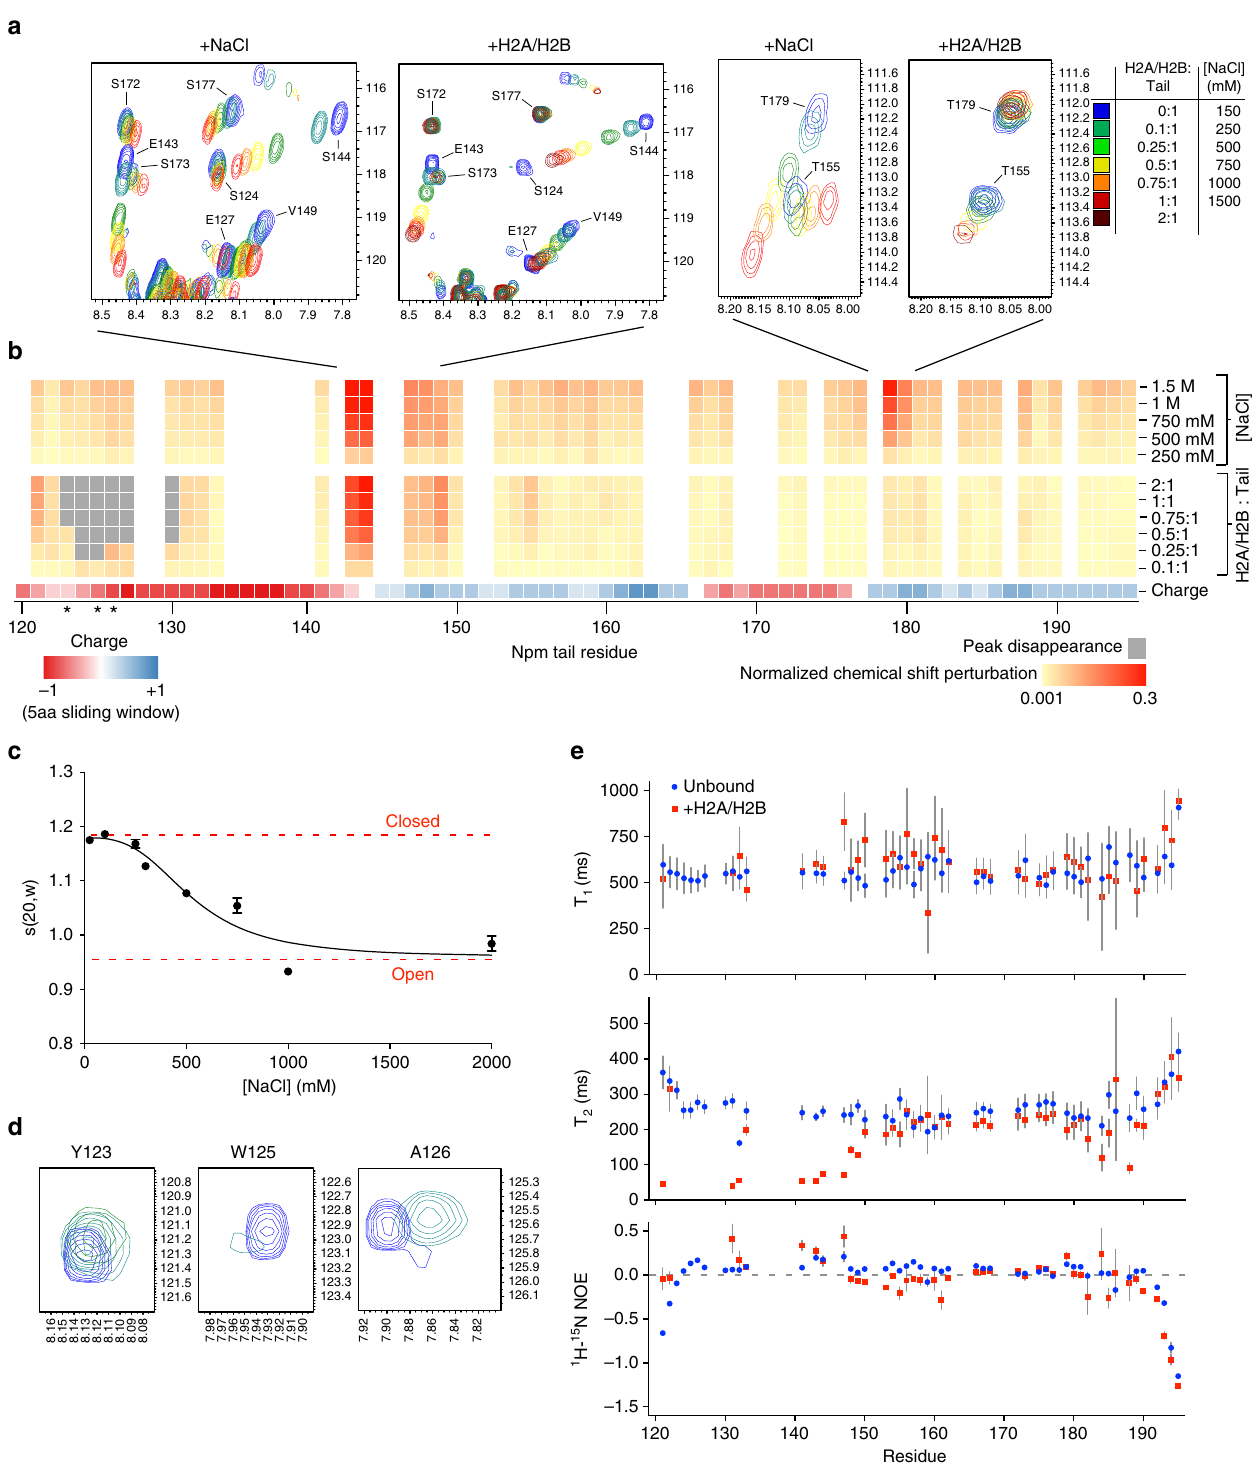
Fig. 2 Biophysical analyses of the conformations of the Npm tail domain. a NMR chemical shift perturbation (CSP) example spectra upon titration of NaCl and H2A/H2B. Blue to red indicates increasing amounts of NaCl or H2A/H2B (legend shown on right). b Heat map of CSP upon titration of NaCl and H2A/ H2B. Yellow to red in the heat map indicates increasing CSP in the spectra and gray indicates binding-induced peak disappearance (legend at bottom right). Starred residues (Y123, W125, and A126) shown in letter D. Npm tail charge displayed using a 5aa-sliding window from − 1 (red) to +1 (blue). c Analytical ultracentrifugation (AUC) sedimentation velocity pro fi le of the Npm tail domain (15 µ M) at various concentrations of NaCl. Sedimentation values normalized to s(20,w). d NMR CSP example spectra of Y123, W125, and A126 upon H2A/H2B titration. Peak disappearance indicates binding to H2A/H2B. e Graph of 15 N relaxation times T 1 (top) and T 2 (middle), and heteronuclear 1 H- 15 N NOE ratios (bottom) of assigned residues of the tail in the unbound (blue circles) and H2A/H2B-bound (red squares) states. Standard errors (gray bars) derived from fi ts to single exponential decay curves for T 1 and T 2 values, and from propagated signal-to-noise for 1 H- 15 N NOE